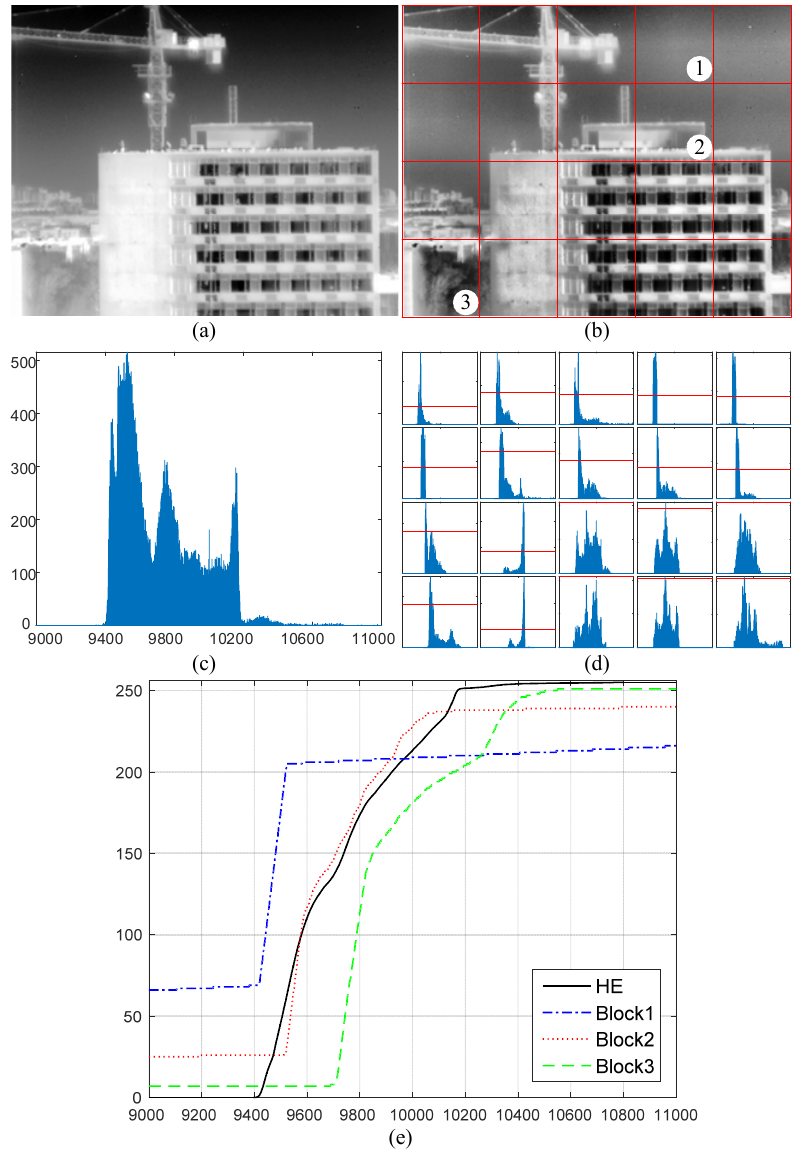
Figure 3. The enhancement result of the given infrared image using contrast-limited adaptive histogram equalization (CLAHE). ( a ) The histogram equalization (HE) result of the given image. ( b ) The CLAHE result of the given image. ( c ) The histogram of the given infrared image. ( d ) The histogram of each sub-block and the red line represents the clip limit. ( e ) The mapping function of HE and the mapping functions of sub-block 1, 2, and 3 in CLAHE. The X-axis ranges in ( c – e ) are set to be (9000,11,000) for better visualization.